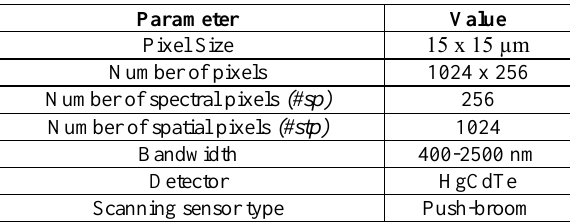
Table 3. Specifications of a customized imaging sensor